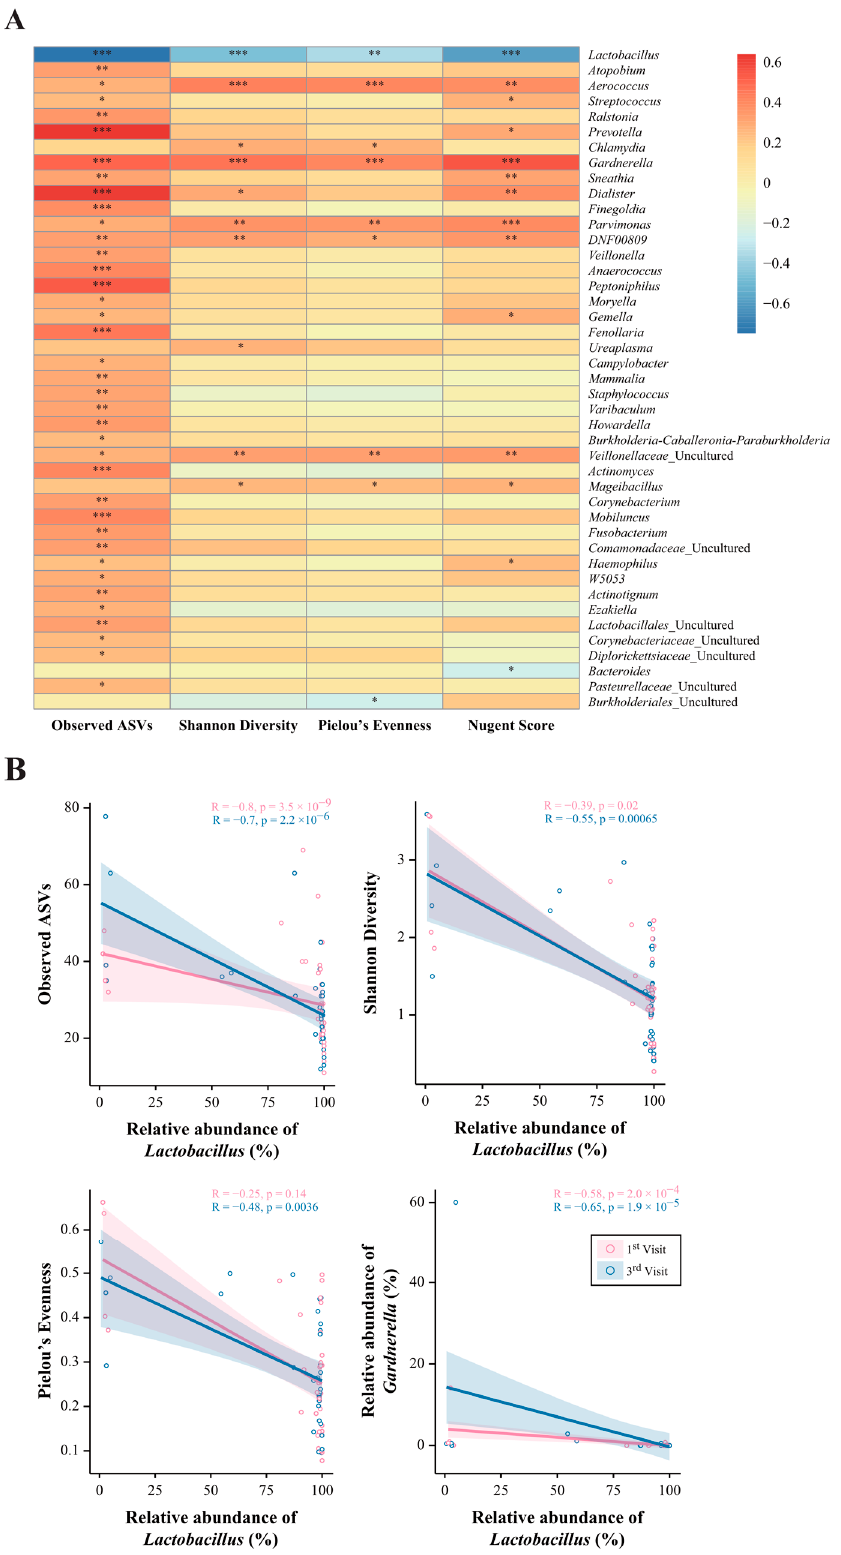
Figure 4. Correlation between parameters, including alpha diversity, Nugent score, and vaginal microbiota at the first and third visits. ( A ) Heatmap showing the correlation between parameters and the vaginal microbiota. ( B ) The correlation between parameters and the abundance of Lactobacillus at the first and third visits. * p < 0.05, ** p < 0.01, *** p <